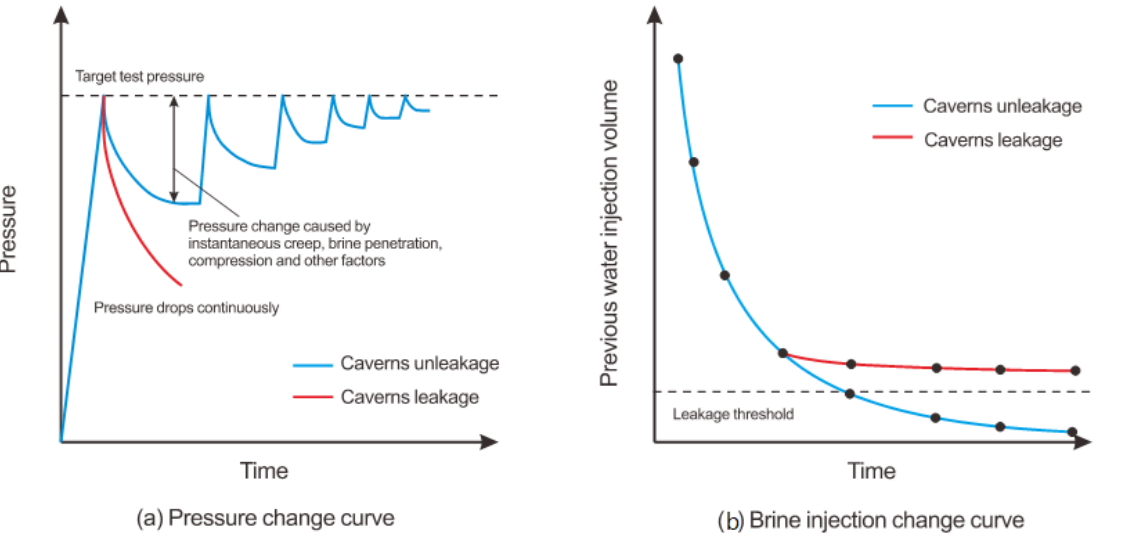
Figure 8. Integrated pressure and flow test